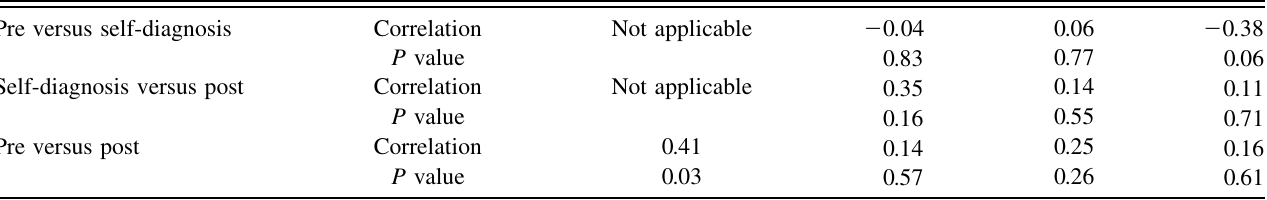
WHAT DO STUDENTS DO WHEN . . TABLE XI. Correlations between pre and self-diagnosis scores, between self-diagnosis and post scores, and between pre and post scores—physics aspect.